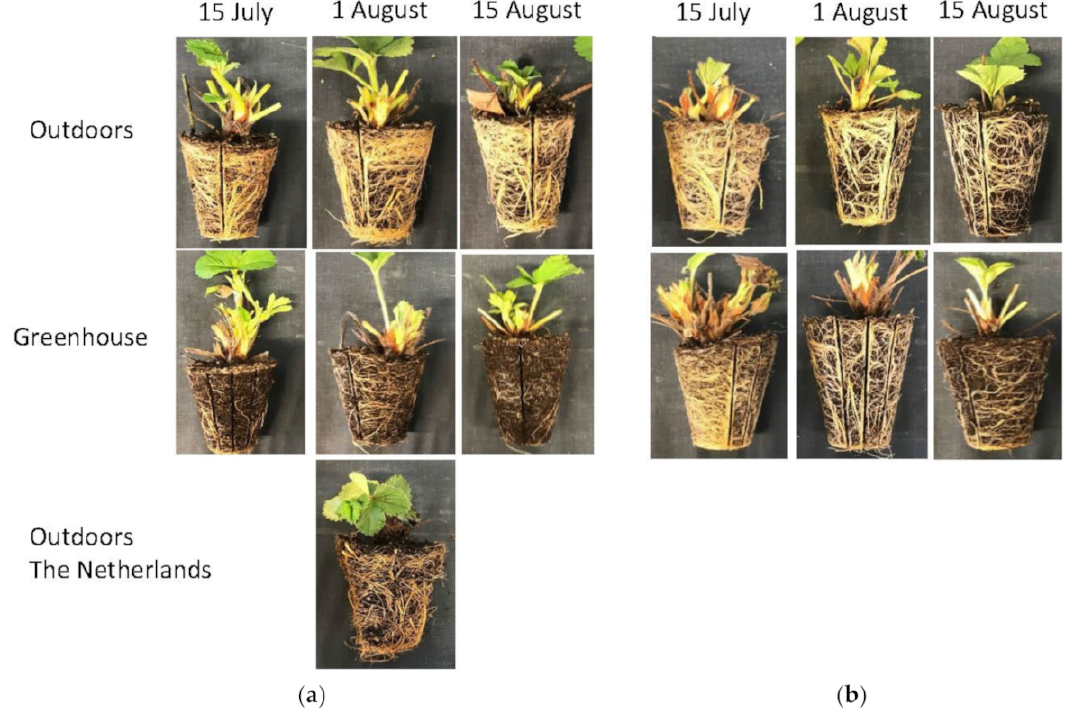
Figure 2. Appearance of representative ‘Favori’ ( a ) and ‘Murano’ ( b ) plants rooted at different dates and raised outdoors or in the greenhouse as indicated when photographed at planting on 14 April 2021. ‘Favori’-plants produced in The Netherlands are included for comparison. Experimental data were subjected to analysis of variance (ANOVA) using the MiniTab ® Statistical Software program package (Release 15; Minitab Inc., State College, PA, USA). Percentage values were always subjected to an arc sin transformation before the